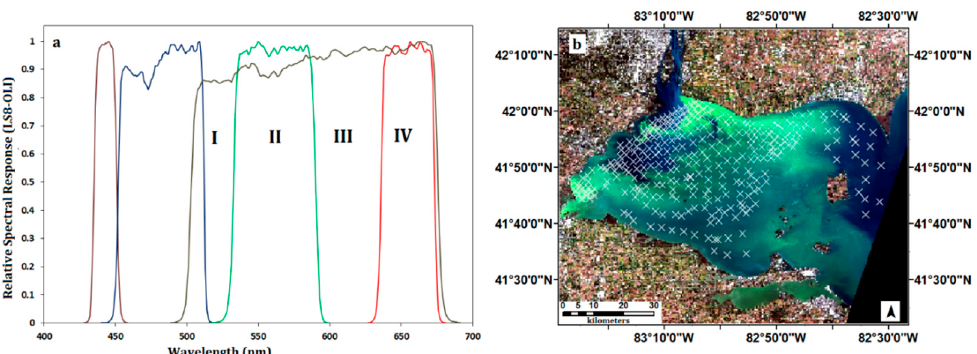
Figure 1. The Landsat 8 Operational Land Imager’s (OLI) relative spectral response (RSR) for visible wavelengths. ( a ) Castagna et al. [5] divided the RSR of the panchromatic band (503–676 nm) into four components (I, II, II, and IV), and Component III is the virtual orange band (590–635 nm). ( b ) The Landsat 8 OLI image (re-sampled to 300 m resolution) of the western basin of Lake Erie showing 300 random pixels used in deriving the virtual orange band.